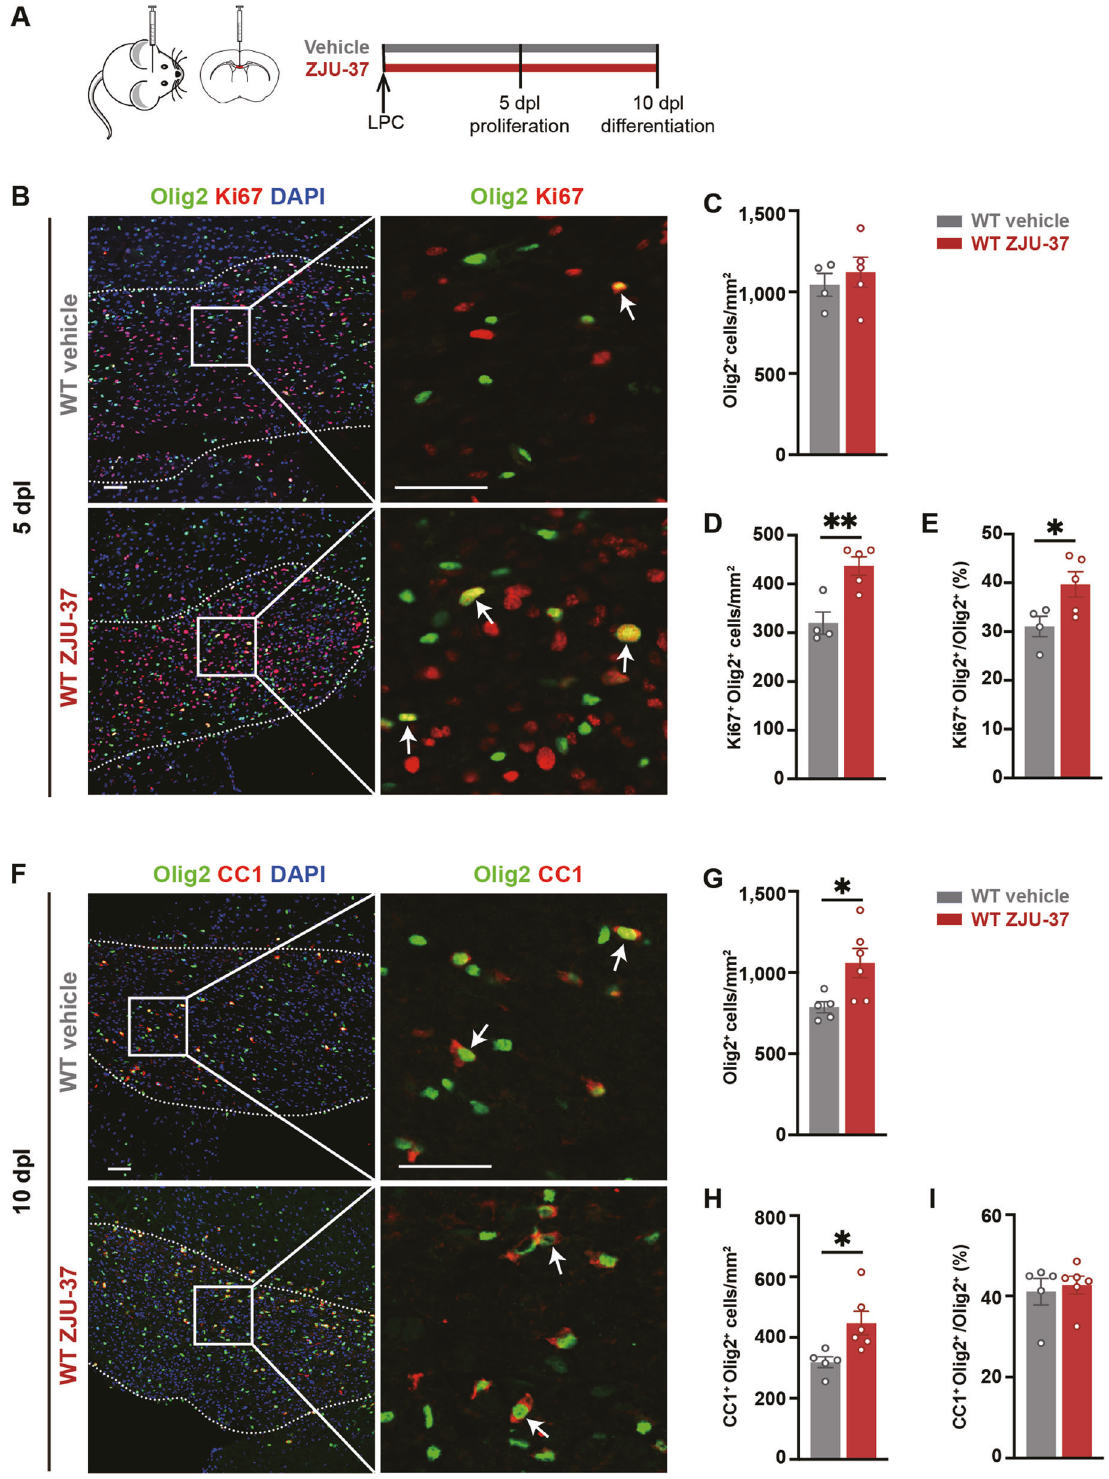
Fig. 4 ZJU-37 promotes OPC proliferation within the demyelination lesion in vivo. A Schematic diagram of the experimental design. B Representative fl uorescence images of proliferating OPCs (arrows, Olig2 + Ki67 + cells) within the demyelination region (dotted line) at 5 dpl. Scale bars, 50 μ m. C – E Quanti fi cation of ( C ) oligodendrocyte lineage cell numbers, ( D ) proliferating OPCs numbers and ( E ) proportion of proliferating OPCs in all oligodendrocyte lineage cells within the demyelination region at 5 dpl (two-tailed t test, n = 4 mice in the vehicle group, n = 5 mice in the ZJU-37 group). F Representative images of differentiated oligodendrocytes (arrows, Olig2 + CC1 + cells) within the demyelination region at 10 dpl. DAPI (blue), Olig2 (green), CC1 (red). Scale bars, 50 μ m. Quanti fi cation of ( G ) oligodendrocyte lineage cell numbers, ( H ) differentiated oligodendrocytes numbers and ( I ) proportion of differentiated oligodendrocytes in all oligodendrocyte lineage cells within the lesion region at 10 dpl (two-tailed t test, n = 5 mice in the vehicle group, n = 6 mice in the ZJU-37 group). All data are presented as mean ± SEM. * P < 0.05, ** P < 0.01, *** P < 0.001, n . s. no signi fi cance. Cell Death Discovery (2022)